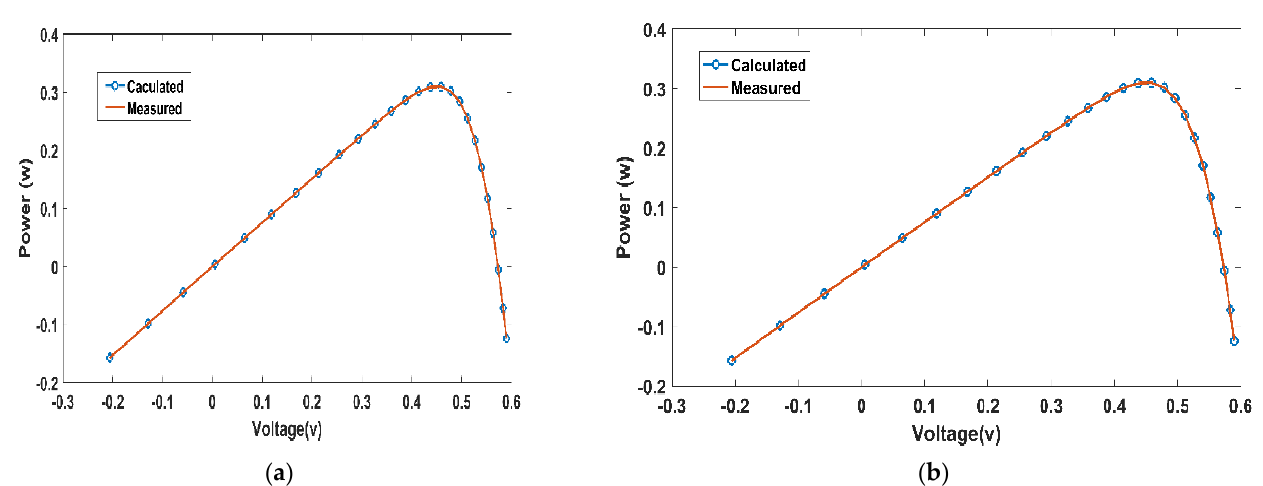
Figure 8. Measured power vs. calculated by CEHO. ( a ) single diode. ( b ) double diode.